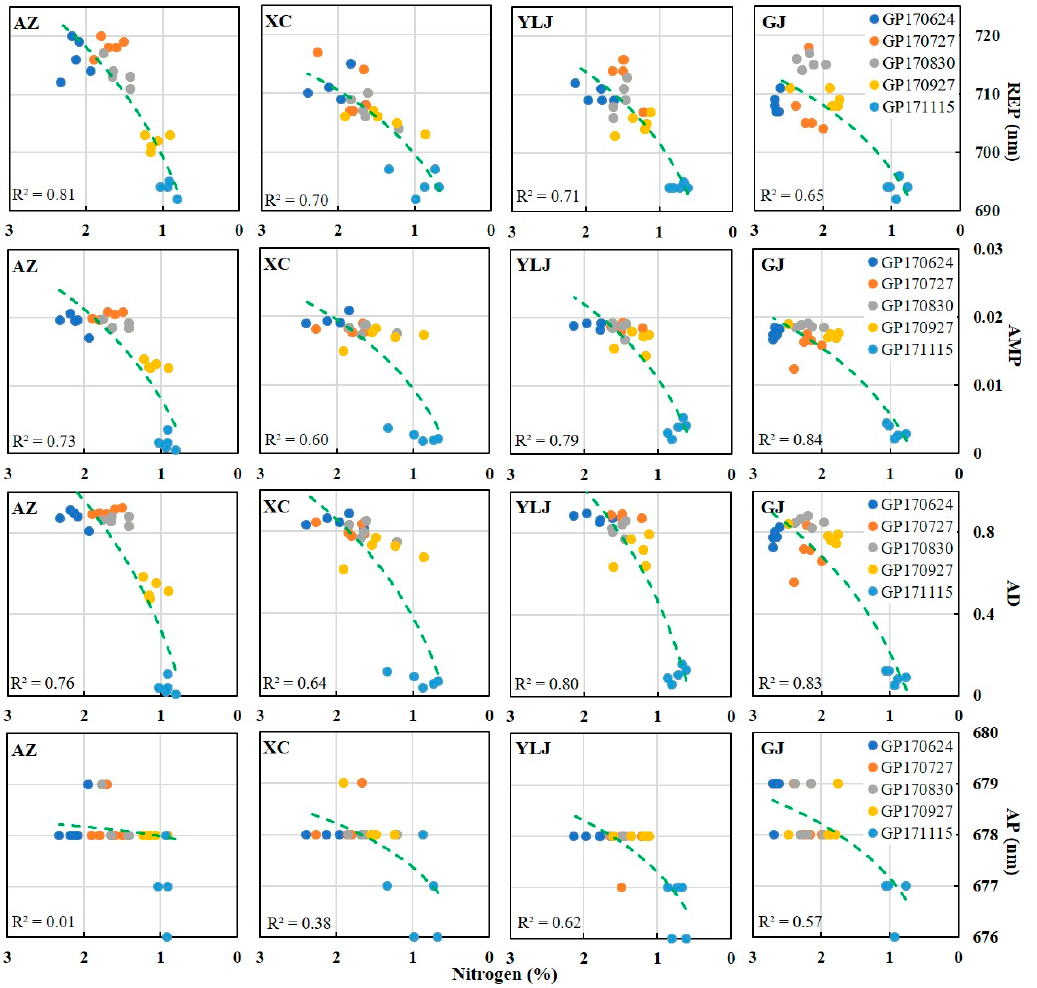
Figure 4. Changes in the red-edge parameters (REP and AMP) and red region absorption features (AP and AD) in different sampling areas and growth periods. The green dotted line indicates the logarithm fitting models between the N content and corresponding spectrum feature parameters.